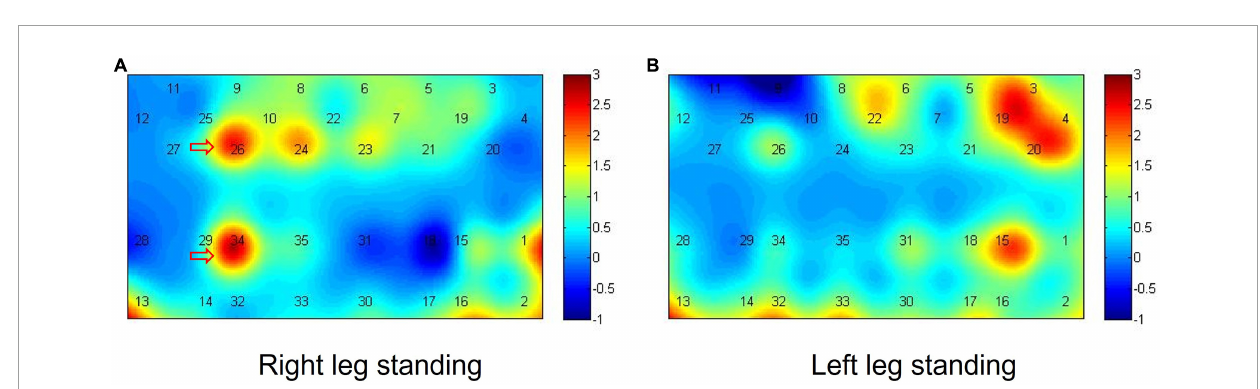
FIGURE3 Activation maps in the single-leg standing tasks. (A,B) The difference of beta value before and after iTBS in the right-leg standing task (A) and the difference of beta value before and after iTBS in the left-leg standing task (B) .